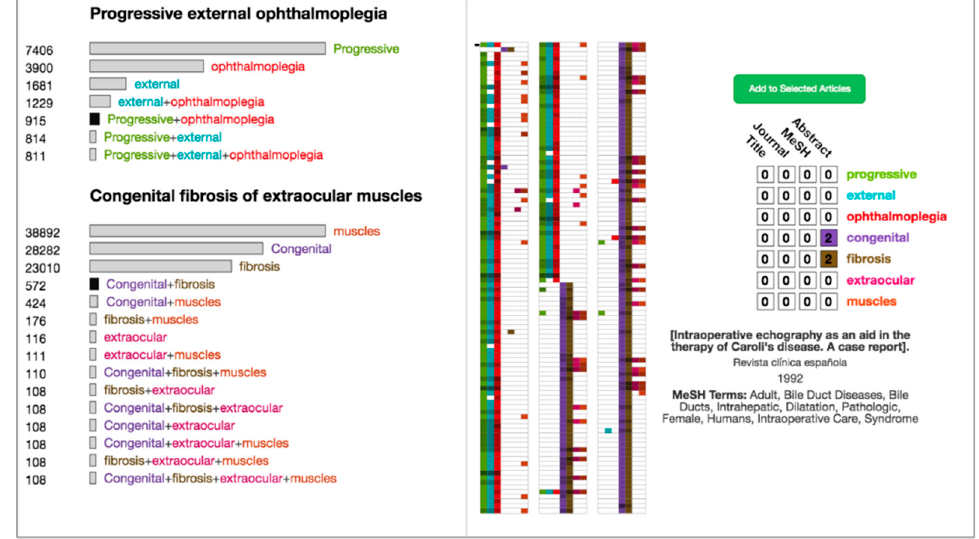
Figure 2. OVERT-MED. Source: image generated on 5 July 2021 with permission courtesy of Insight Lab, Western University, London, Ontario, Canada http://insight.uwo.ca/ (accessed on 5 July 2021).